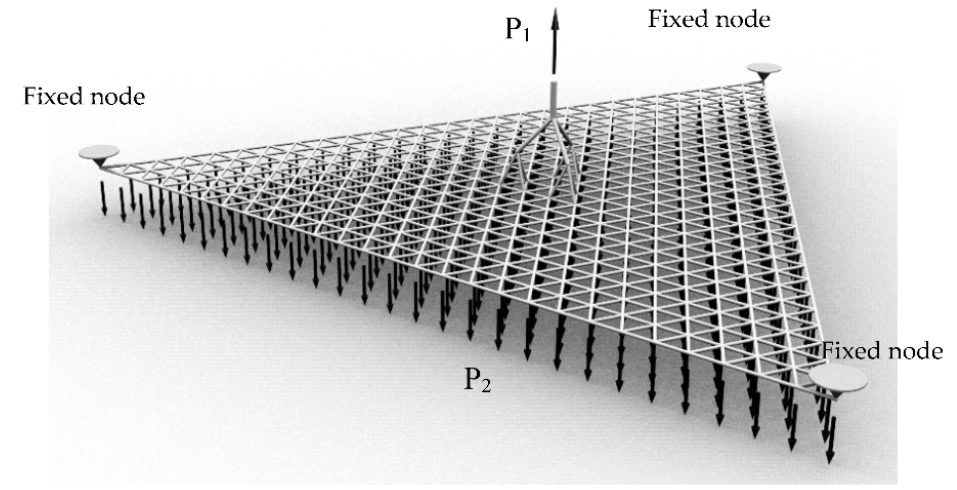
Figure 2. Initial hanging model.